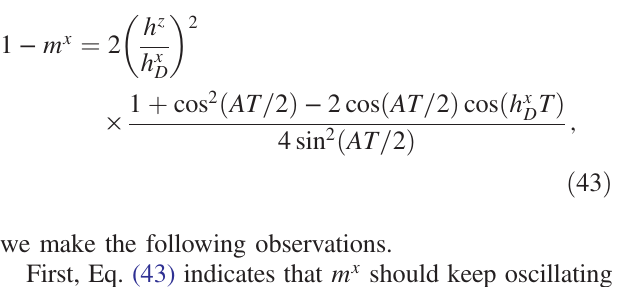
, Eq. (3)]. The top row shows DE